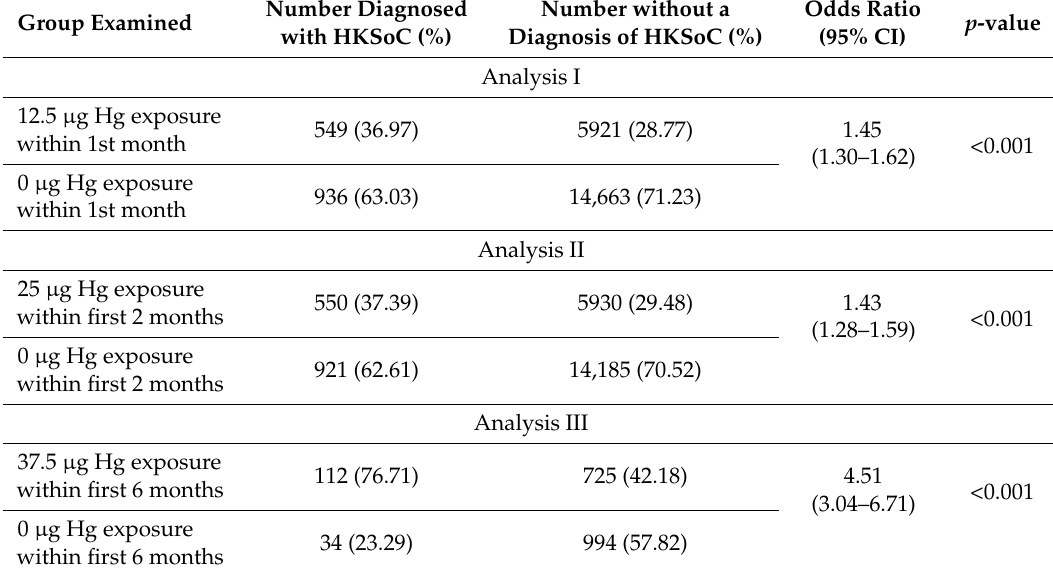
Table 2. A summary of organic-mercury exposure from Thimerosal-preserved hepatitis B vaccine administration between cases diagnosed with hyperkinetic syndrome of childhood (HKSoC) and controls within the Vaccine Safety Datalink database.